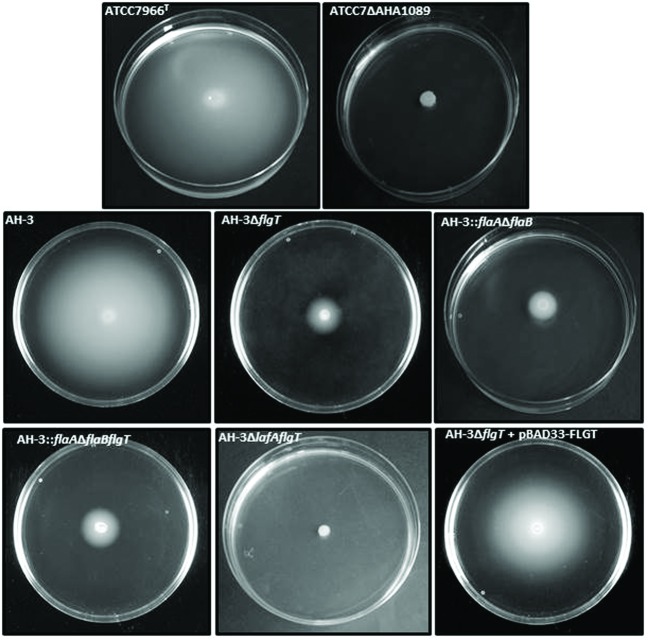
Motility of A. hydrophila strains: AH-3, ATCC7966T, ATCCΔAHA1089, AH-3ΔflgT, AH-3::flaAΔflaB (AH-3 non-polar flagellum mutant), AH-3::flaAΔflaBflgT, AH-3ΔlafAΔflgT, and AH-3ΔflgT harboring plasmid pBAD33-FLGT grown 20 h at 25°C on soft agar. The mutant complemented with pBAD33 plasmid was grown with 0.2% L-arabinose.